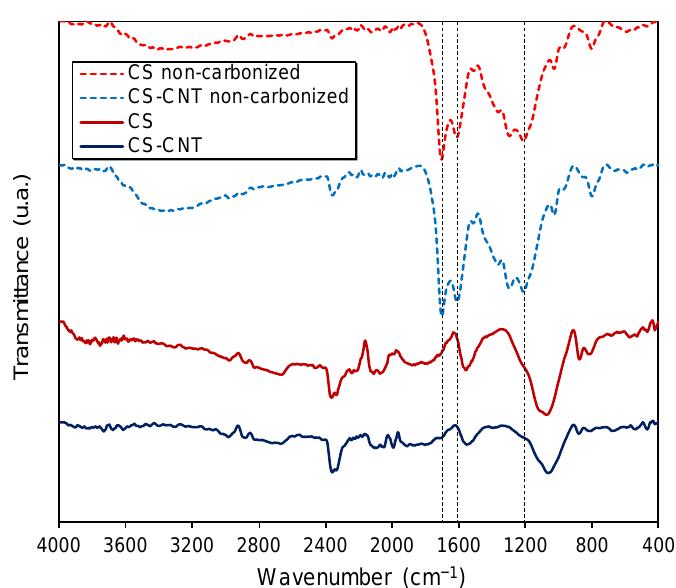
Figure 2. N 2 adsorption-isotherms obtained at −196 °C for pure glucose and glucose–carbon hy- brids.